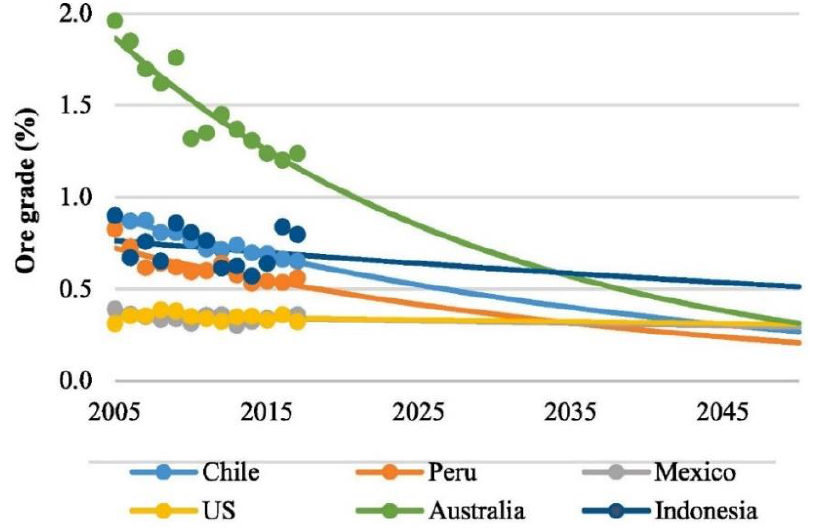
Figure 2. Reported (symbols) and forecasted (lines) ore grade by country (Adapted from [43] with permission).